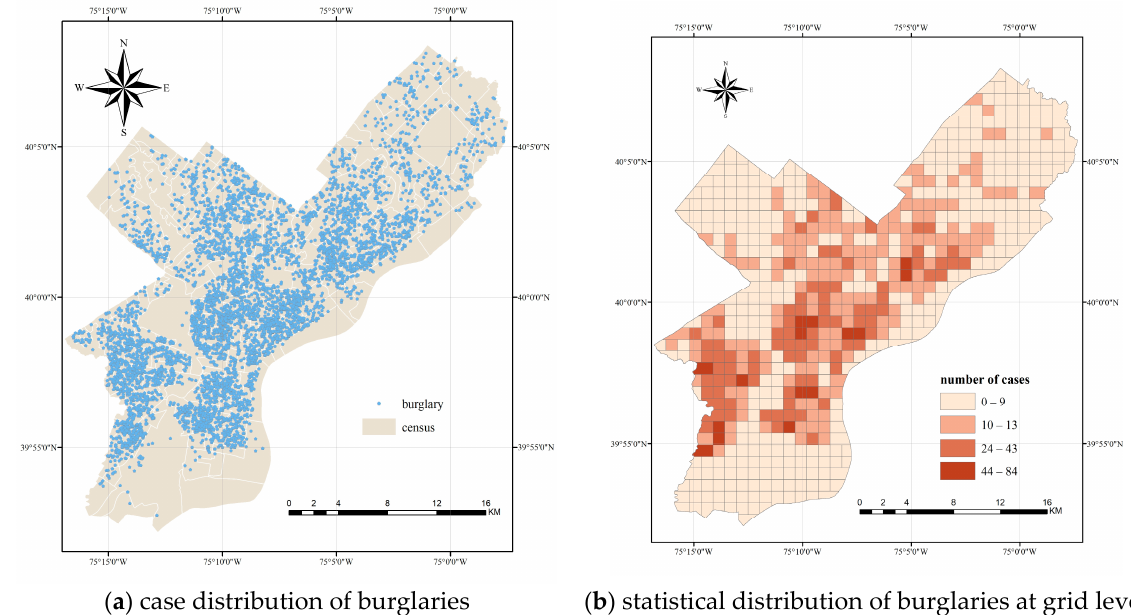
Figure 3. Study area and the distribution of burglaries in Philadelphia. To facilitate the visual comparison and quantitative analysis, the study area is divided into regular grids with the size of one kilometre. The grids at the boundary with areas of less than 0.5 square kilometres were merged with neighboring units, and 622 spatial units were obtained. Then, the number of cases falling in each cell were treated as the attribute value of cells. The distribution of crime cases at the grid level is shown in Figure